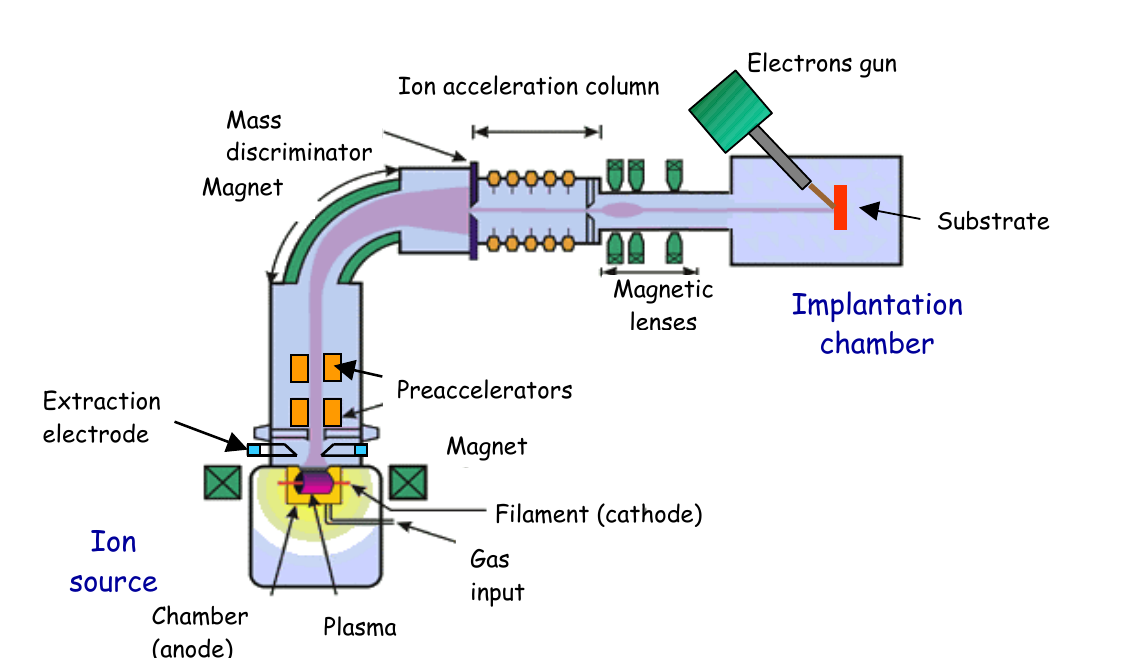
FIGURE 5. Survey of the sol-gel method.